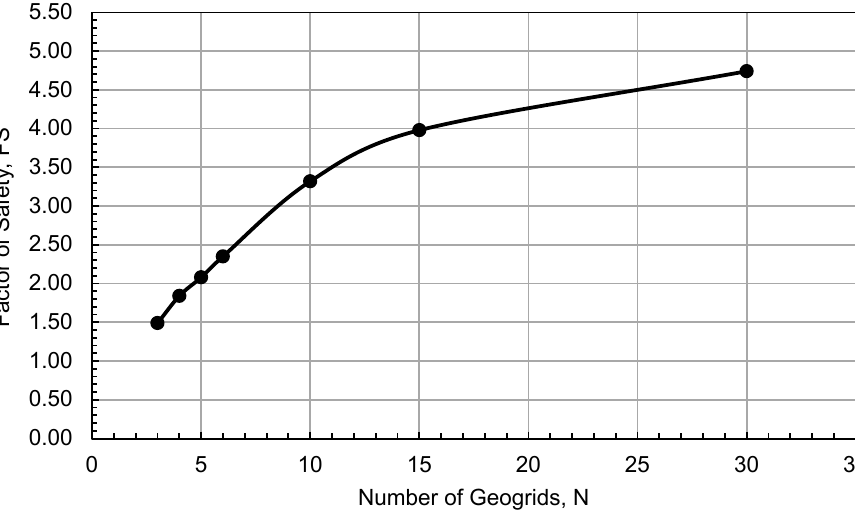
Figure 10. Variation in FS with N.